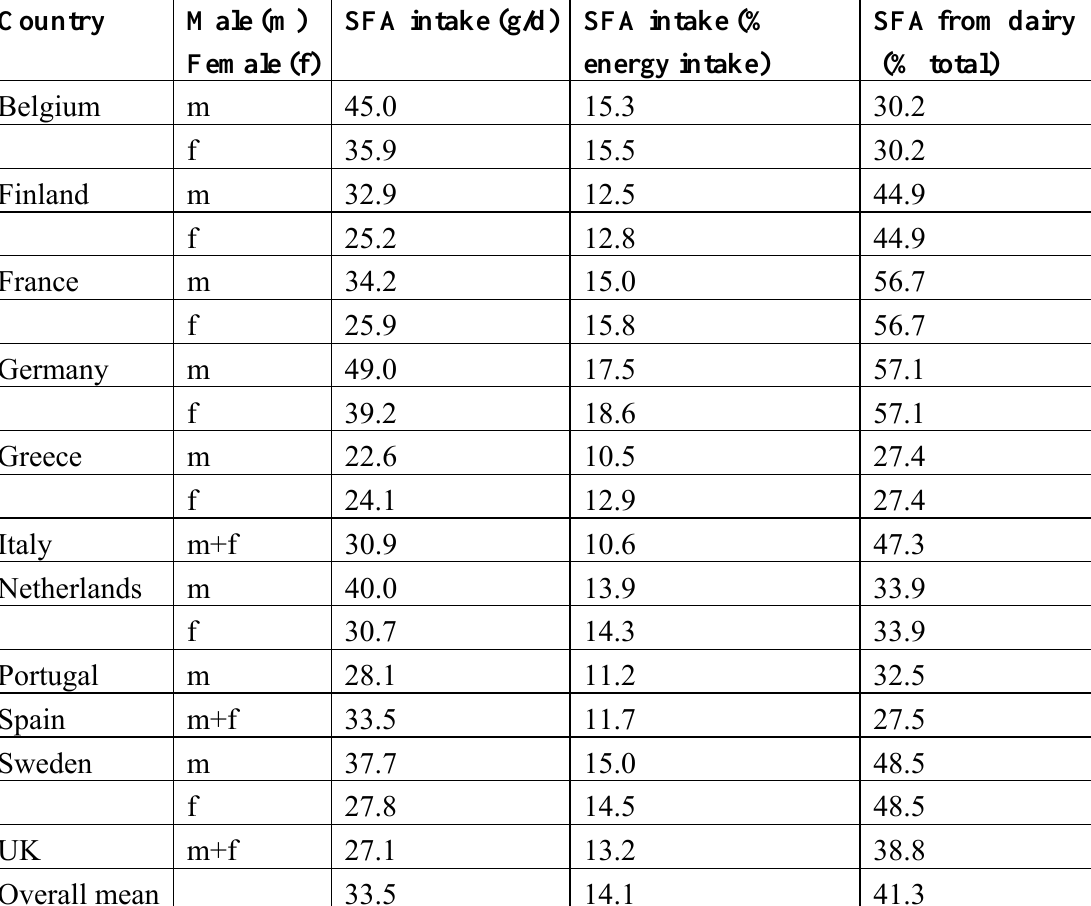
Table 1. Intakes of saturated fatty acids (SFA) and the proportion supplied by dairy products in 11 EU Member States (adapted from